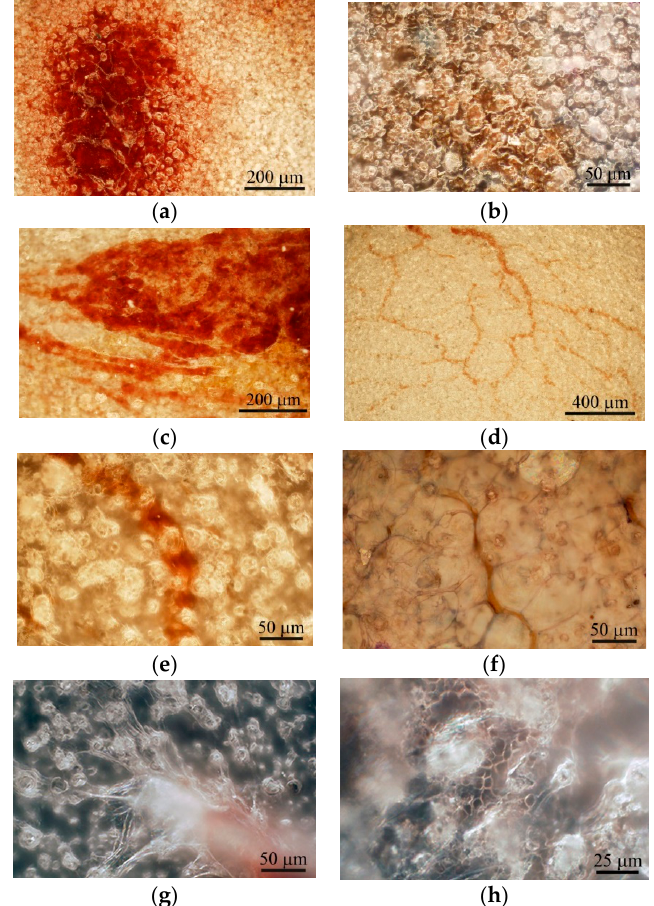
Figure 4. Surface of the microarc rough CaP coating on the titanium substrate after subcutaneous implantation in mice. ( a ) One; ( b ) two; ( c ) three; ( d ) four; and ( e ),( f ) five weeks after implantation. ( g ) Blood vessel stalks; ( h ) erythrocytes in capillaries between surface spherulites at 5 weeks after subcutaneous implantation. ( b ),( g ),( h ): Bright—and dark-field reflecting optical microscopy was used. Hematoxylin and eosin staining ( b ),( f ). Scale bars 25–400 µm.